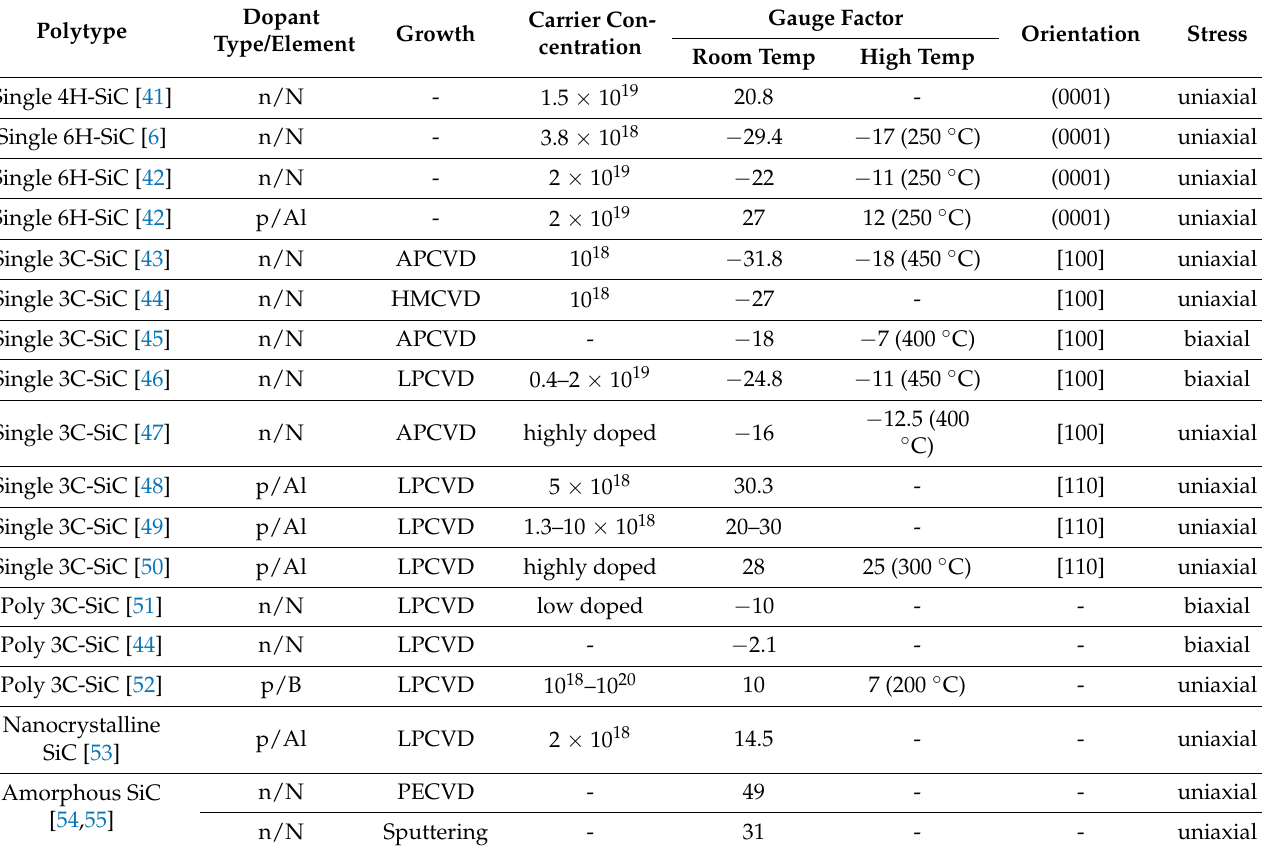
Table 1. Effect of typical dopants on the properties of SiC based piezoresistive